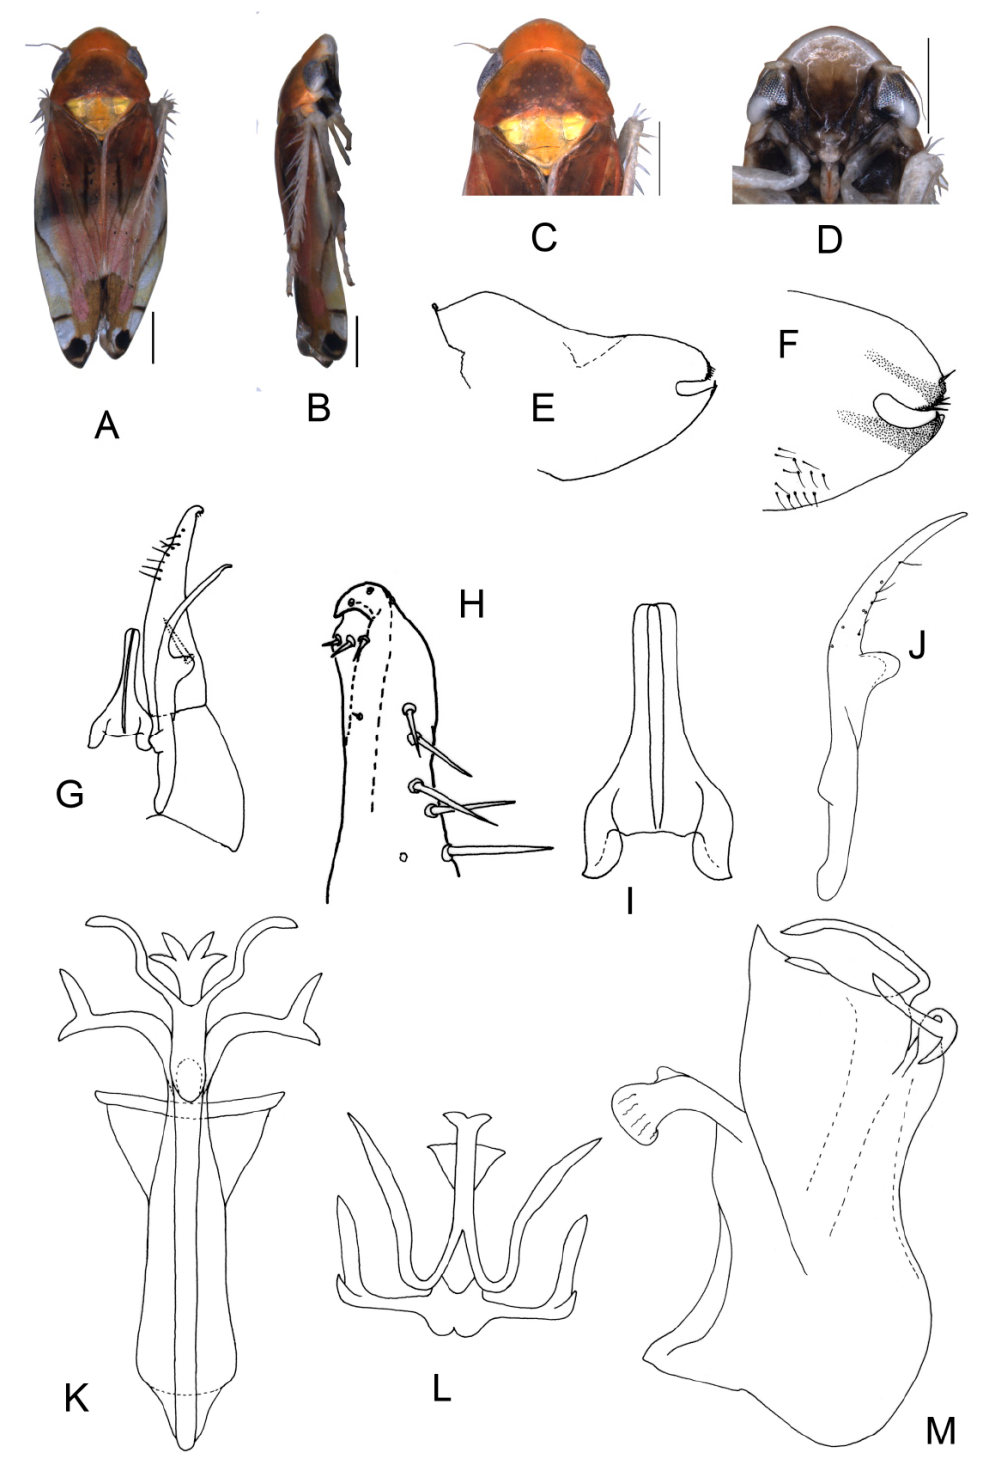
Figure 6. Eurhadina ( Singhardina ) scalesa sp. nov. : ( A ) habitus, dorsal view; ( B ) habitus, lateral view; ( C ) head and thorax, dorsal view; ( D ) face; ( E ) male pygofer side, lateral view; ( F ) hind part of pygofer, lateral view; ( G ) subgenital plate, connective, paramere and sternite IX, dorsal view; ( H ) apex of subgenital plate, dorsal view; ( I ) connective, dorsal view; ( J ) paramere, dorsal view; ( K ) aedeagus, posterior view; ( L ) apex of aedeagal shaft, dorsal view; and ( M ) aedeagus, lateral view. Scale bars: 0.5 mm.